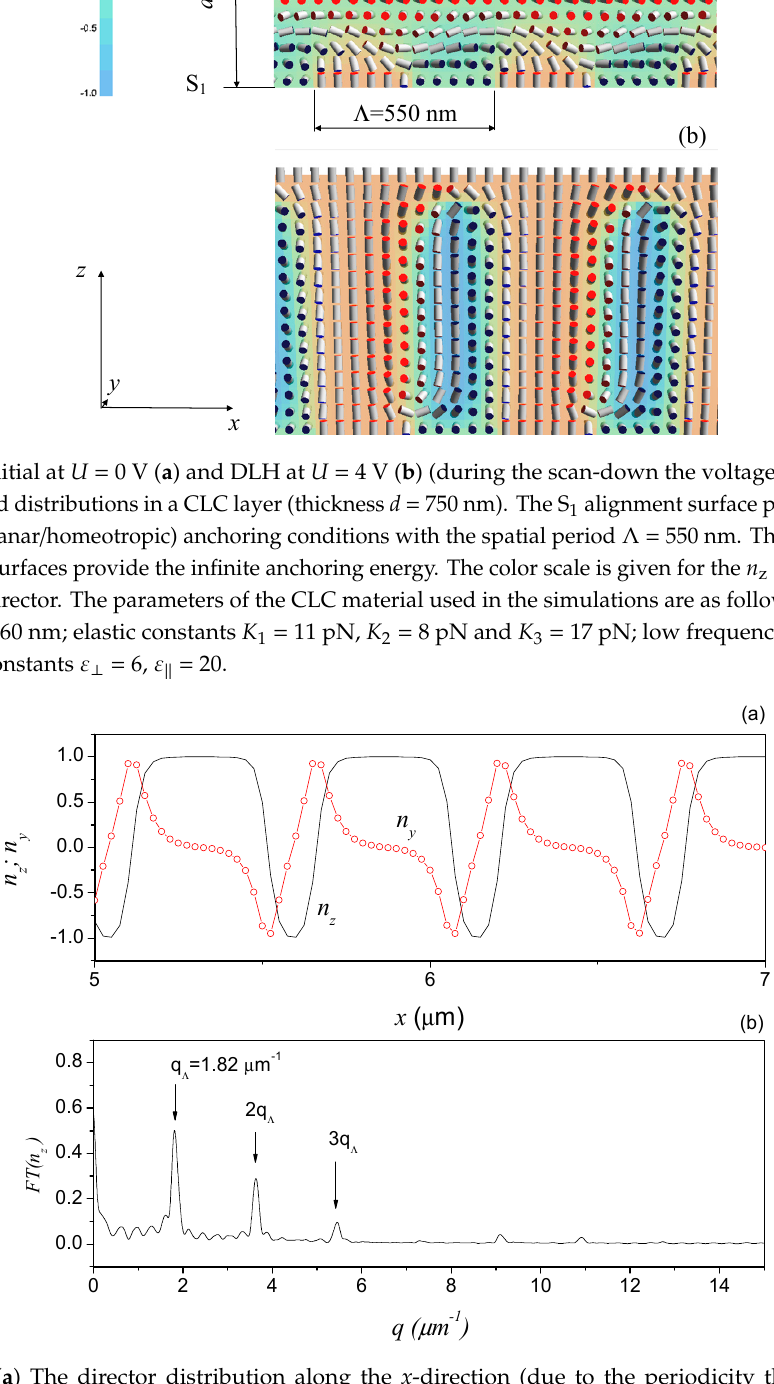
Figure 5. ( a ) The director distribution along the x -direction (due to the periodicity the director distribution is shown only for the central part of the virtual CLC cell from x = 5 to x = 7 µ m) in middle of the CLC DLH-layer at U = 7 V; ( b ) Fourier transform spectrum characteristic of the spatial distribution of the z -component ( n z ) of the director along the x -axis in the middle of the DLH layer at U = 7 V.